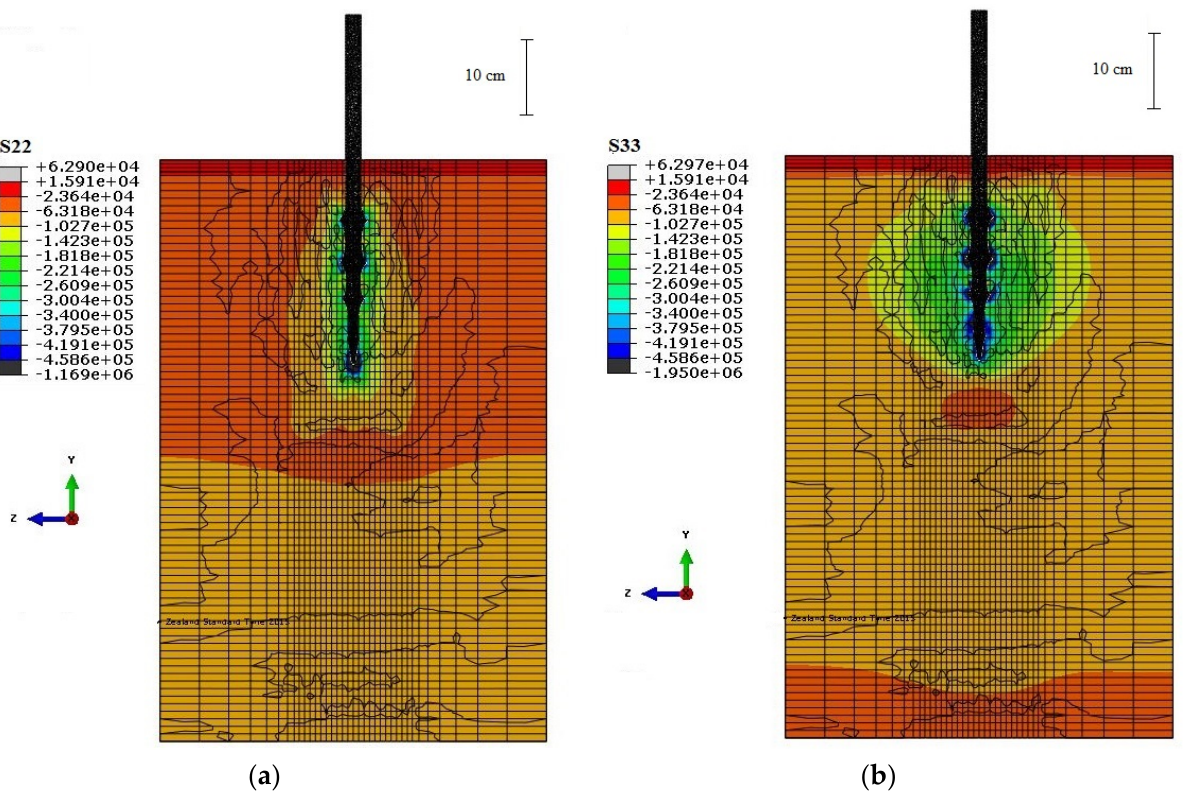
Figure 8. Contour of ( a ) vertical stress (in Pa); and ( b ) horizontal stress (in Pa) in the soil after one complete rotation. The figure scale is indicated.